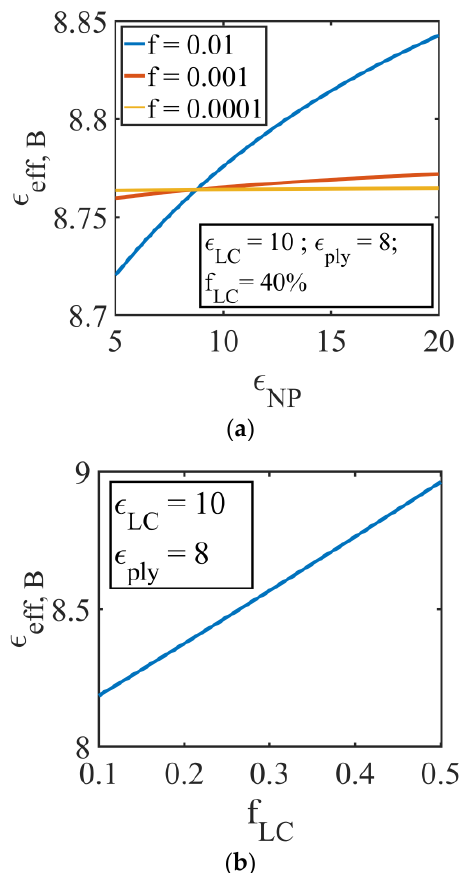
Figure 7. ( a ) Effective permittivity for the NPs-doped PDLC, versus NP permittivity, ε NP , (Equation (18)) at a constant LC volume fraction f LC = 0.4 and for different NP volume fractions f NP : 0.01; 0.001; and 0.0001. LC permittivty ε LC = 10, polymer permittivity ε ply = 8; ( b ) representa- tion of undoped PDLC effective permittivity in the Bruggeman model versus LC volume fractions, Equation (14), at constant LC permittivty ε LC = 10, polymer permittivity ε ply =